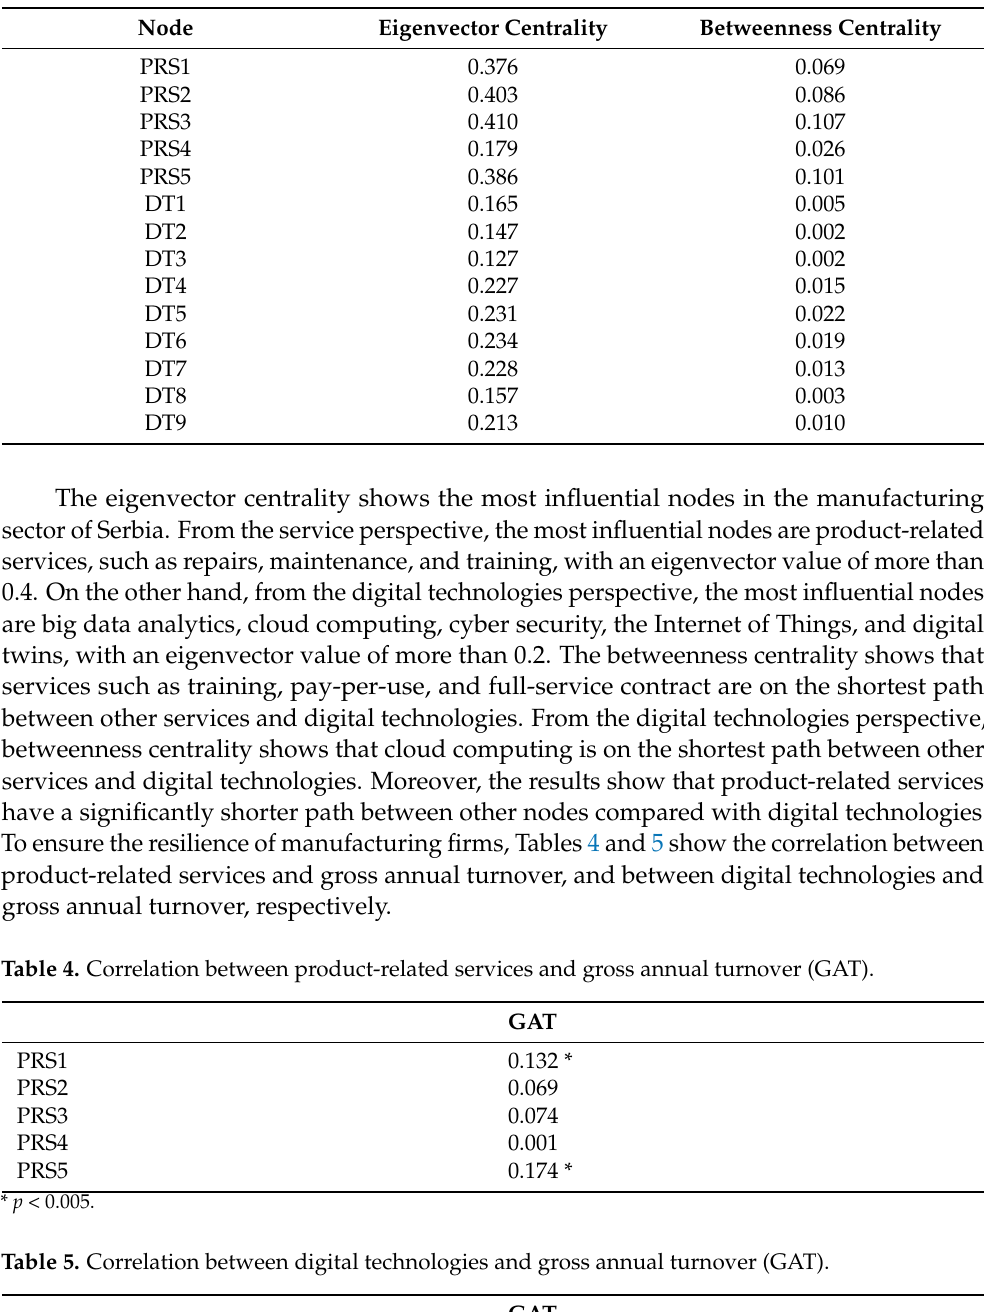
Table 3. Centrality analysis in the manufacturing network.